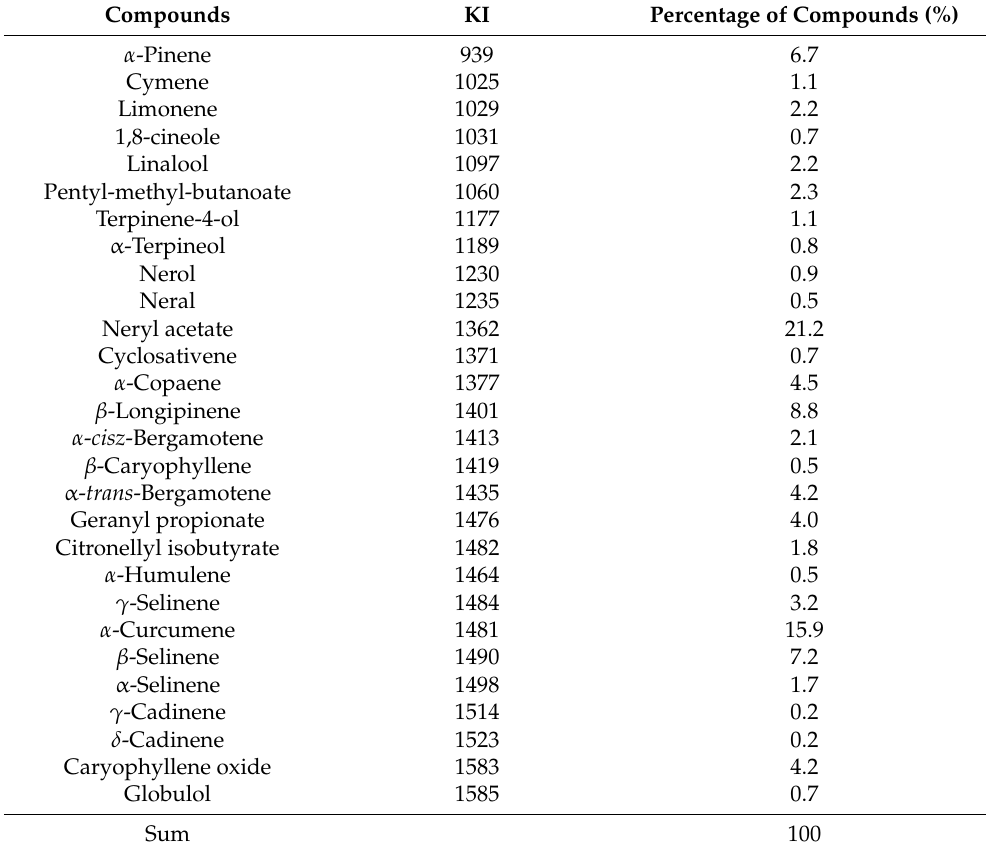
Table 1. Percentage composition of immortelle oil. Values are averages of three parallel